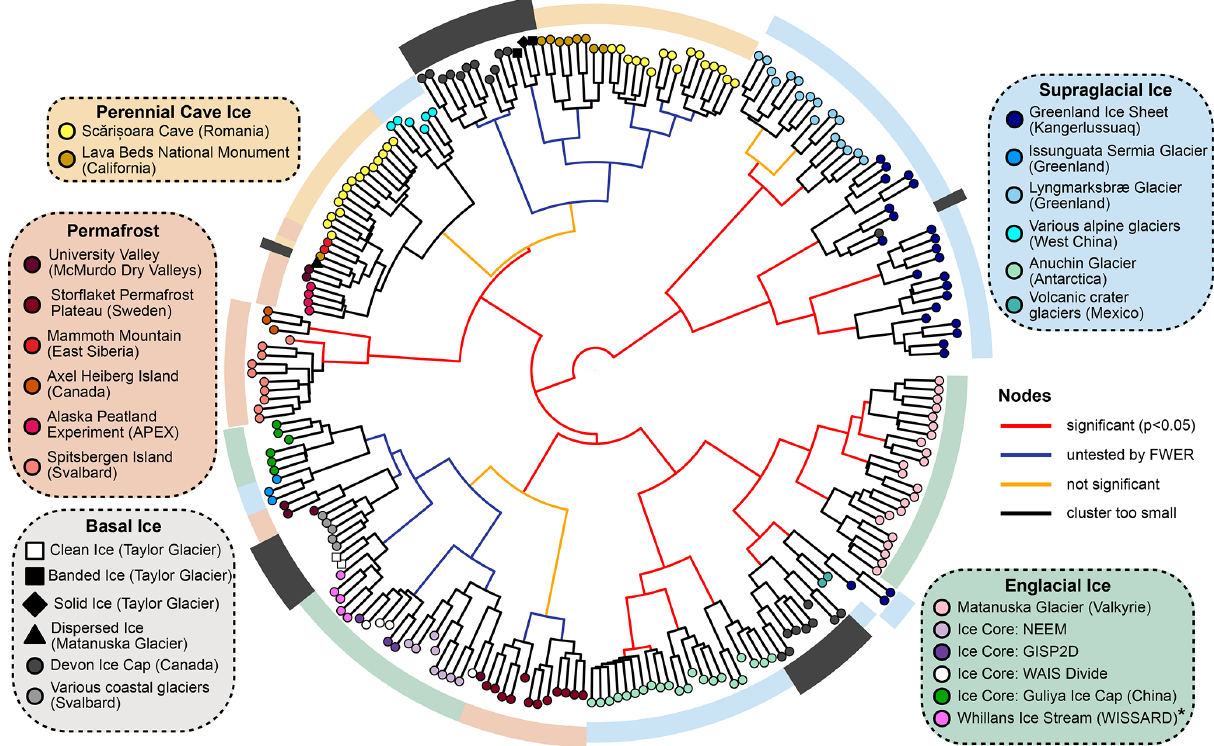
Figure 3. Hierarchical cluster analysis of UF distances between samples using Ward’s minimum variance method. The significance of each node was calculated with a Monte Carlo simulation using the sigclust2 R package. Family-wise error rate (FWER) was controlled across the dendrogram using a sequential testing procedure starting at the central node. * WISSARD samples were collected via hot-water drilling and thus represent an integrated sample of firn and englacial